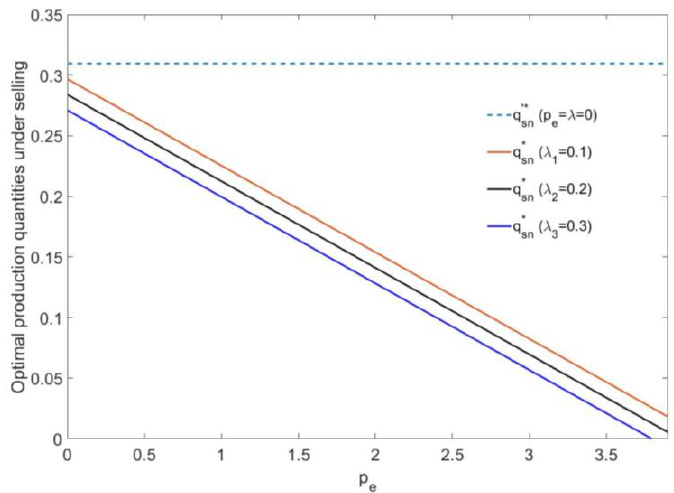
Figure 2. The relationship between the production quantities of the manufacturer and p e under a selling strategy.